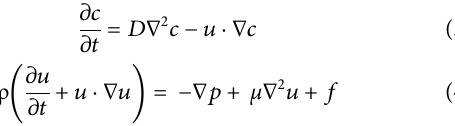
Frontiers in Chemistry |